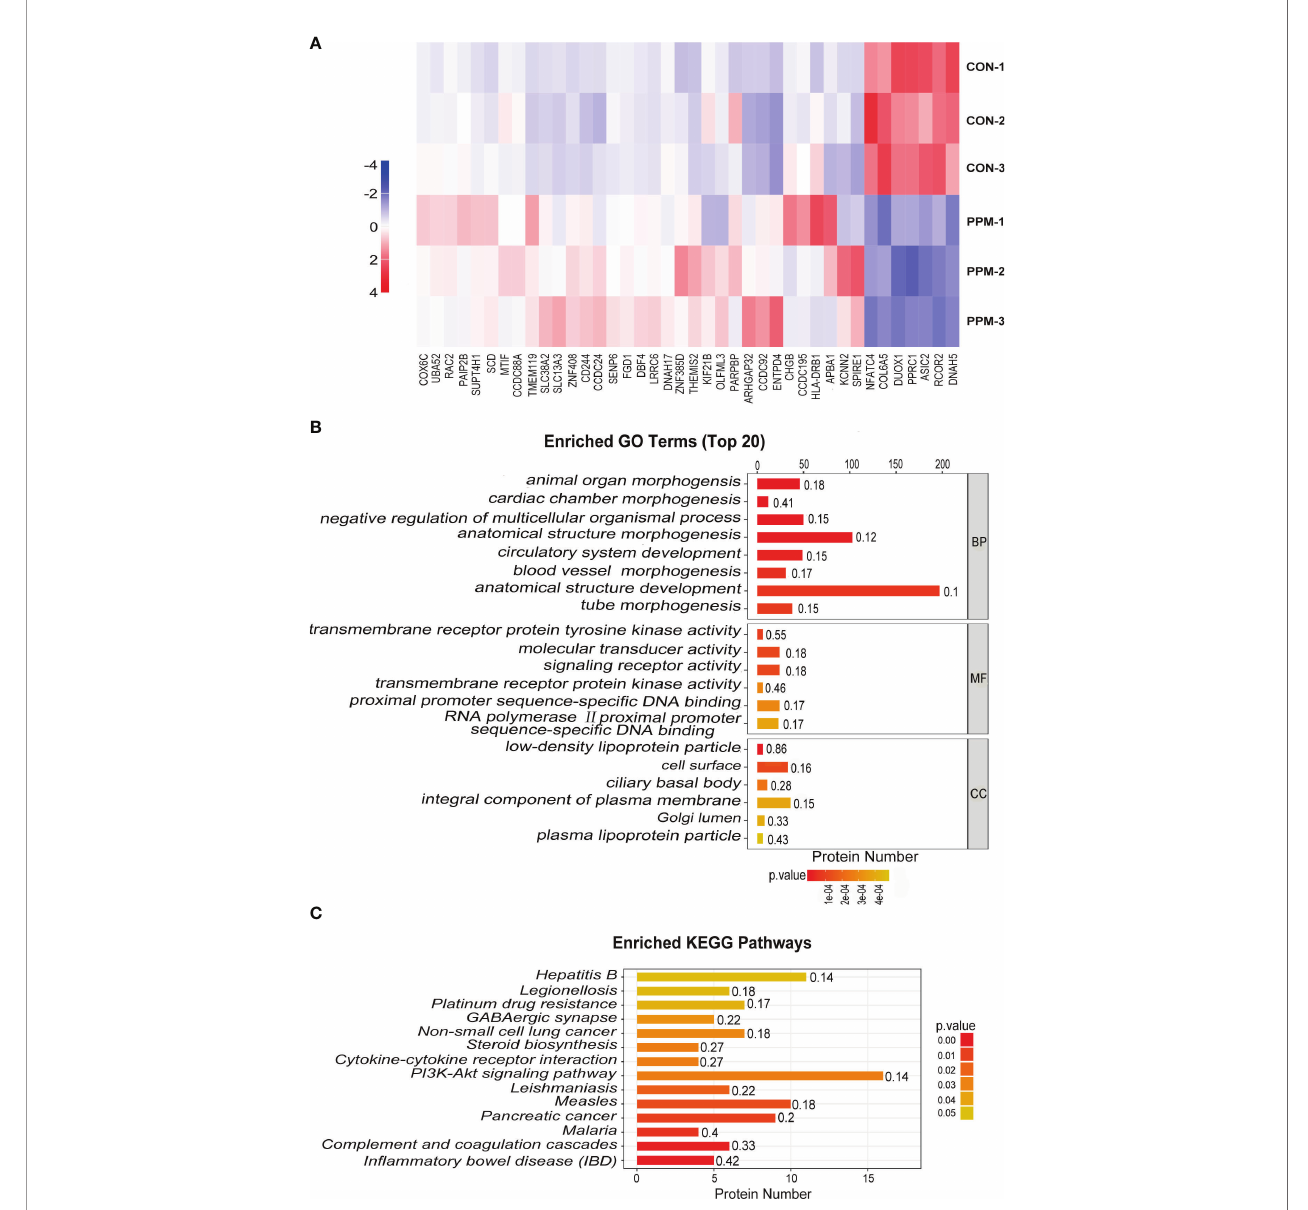
FIGURE 5 | Quantitative proteomic analysis of control and PPM-treated HCT 116 cells and bioinformatic analyses of the differentially expressed proteins (DEPs). (A) Hierarchical clustering of DEPs between the control and PPM-treated groups. The heatmap is a visualized demonstration of the protein distribution in different samples. Columns represent the proteins and rows represent the groups of cells. The red color represents high expression and blue color represents low expression. A total of 33 of the upregulated proteins and seven of the downregulated proteins showed >2 fold-changes with P < 0.05. (B) Top 20 enriched GO terms using Fisher ’ s exact test for the biological process (BP), molecular function (MF), and cellular component (CC) categories. The vertical axis represents GO terms in each category; the horizontal axis demonstrates the protein number of each item. The numbers beside the bars are enrichment factors, which represent the signi fi cance and reliability of proteins enriched in each item. (C) Enriched KEGG pathways associated with the DEPs. The color of the bar represents the P -value calculated using Fisher ’ s exact